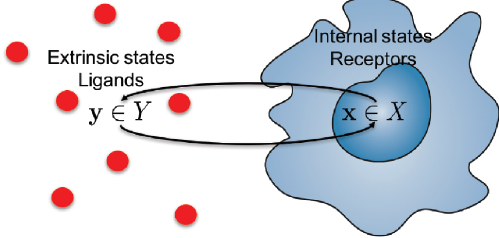
Figure 2: Sketch of communication between cell and its